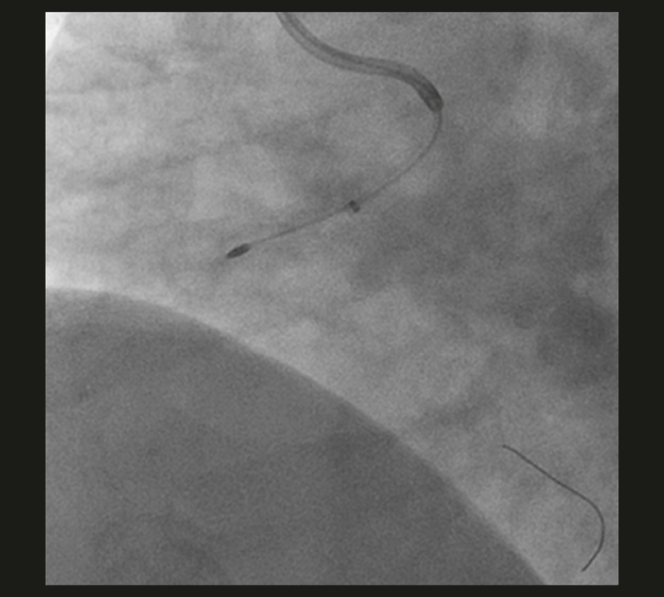
Figure 2: Advancement of a 1.5 mm burr through the Dio thrombus aspiration